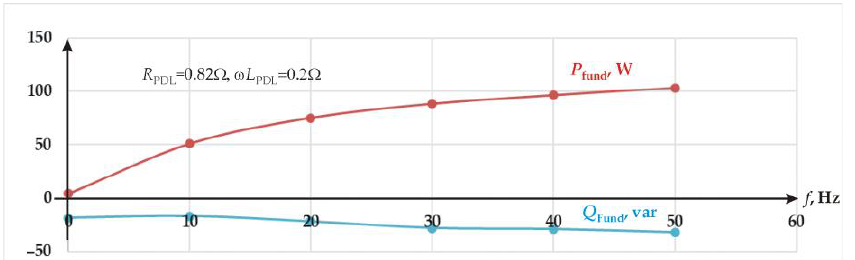
Figure 16. Active and reactive power provided or drawn out by Siemens Micromaster 420 single- phase diode rectifier supply-side VFD as a function of VFD